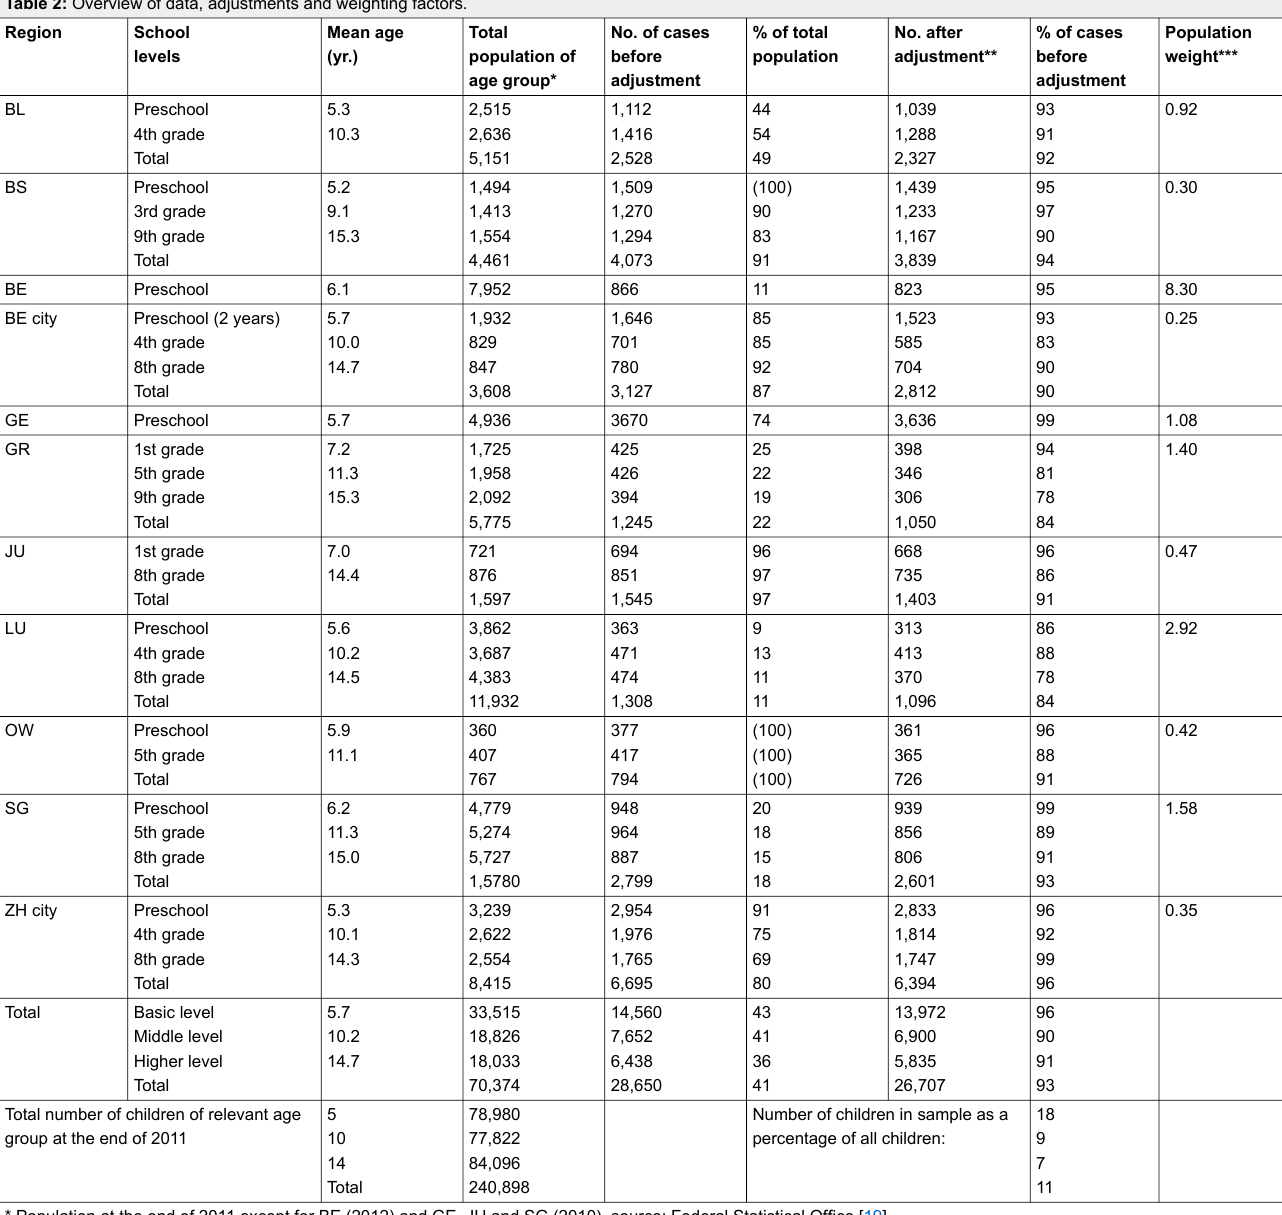
Table 2: Overview of data, adjustments and weighting factors. Region